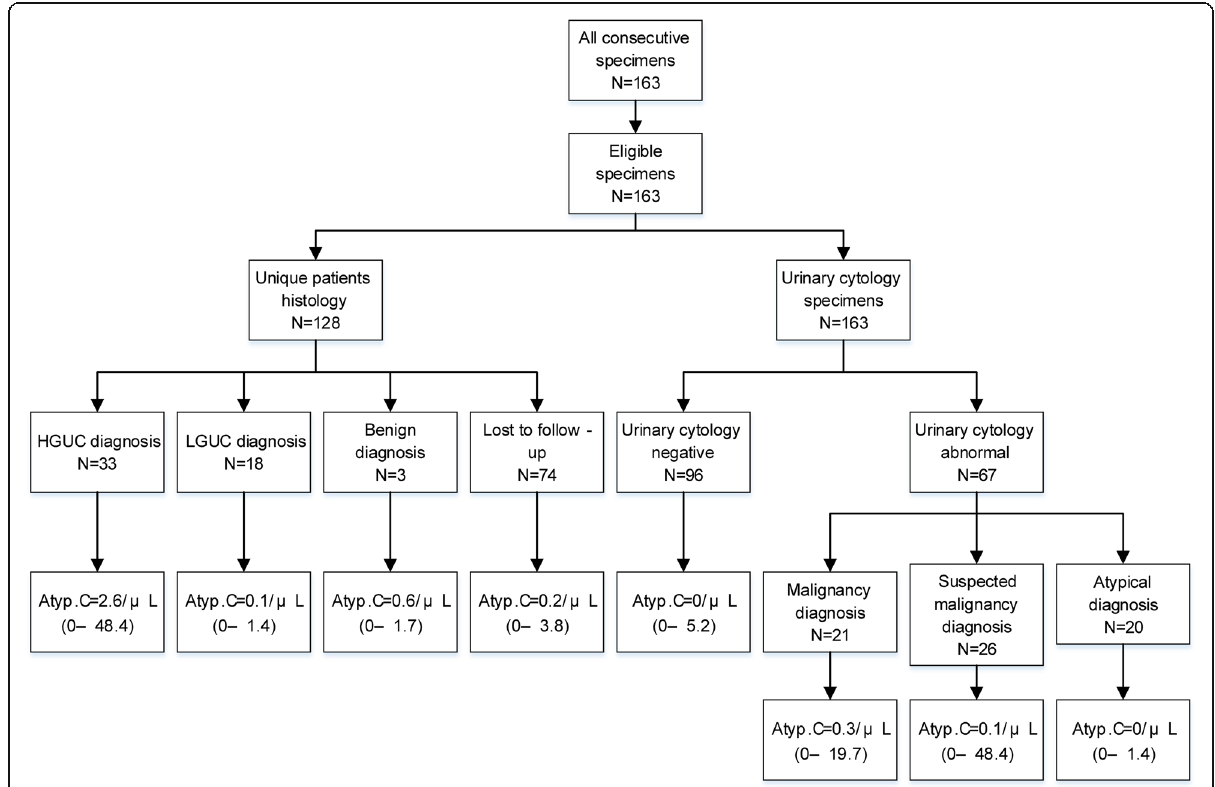
Fig. 2 A study flow diagram according to patient demographics and the results of Atyp.C intensity